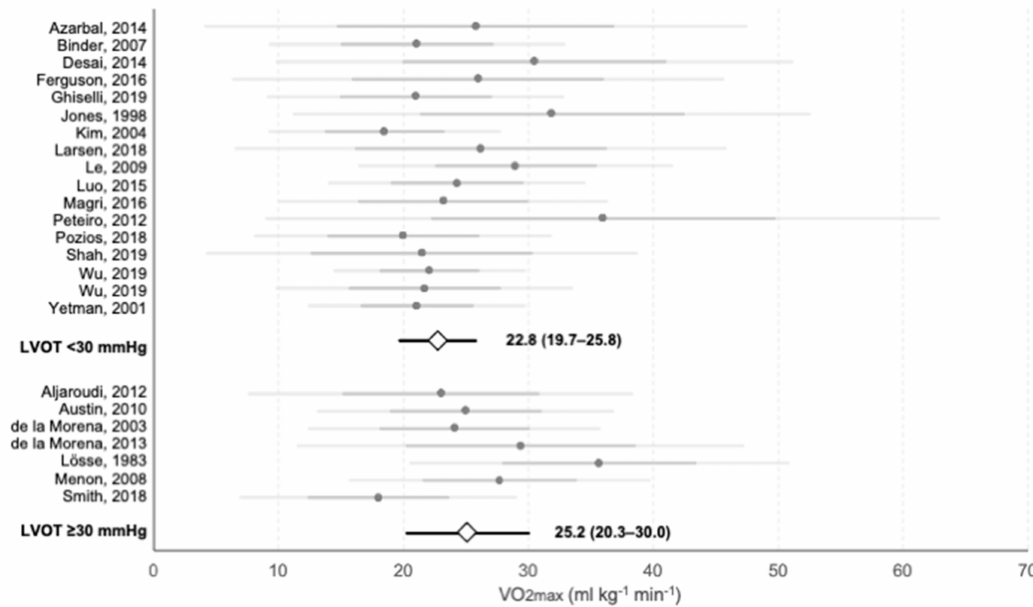
Figure 6. Meta-analysis of the VO2max reported on each study and average values for each LVOT group. Grey points represent the average value of each individual study. Darker horizontal lines intersecting them represent the upper and lower value of the mean ± SD, and lighter horizontal lines show 95% CI. White rhombi intersected by a black line represent the mean VO2max and 95% CI of each LVOT group as extracted from the meta-analysis. The numerical values of each subgroup are